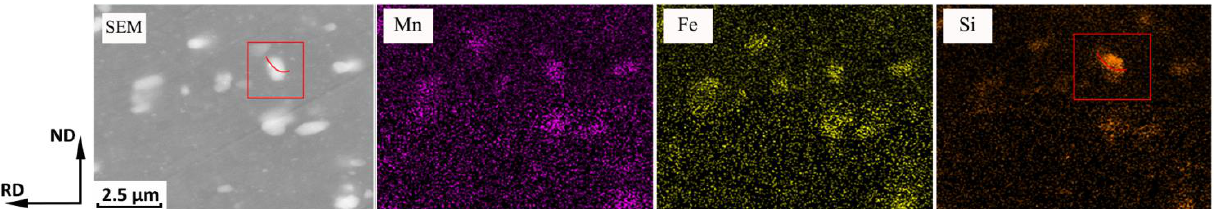
Figure 3. SEM microimages of the dispersoids in the core layer of three experimental alloys before brazing: ( a ) Sample A, ( b ) Sample B, ( c ) Sample C.